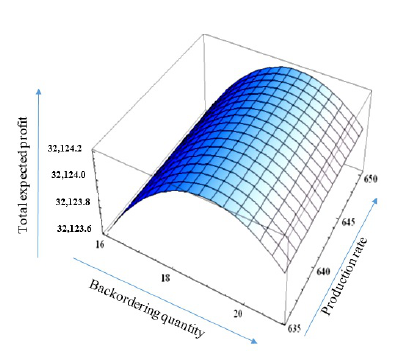
Figure 4. Total Expected Profit (TEP) versus backordering quantity and production rate.